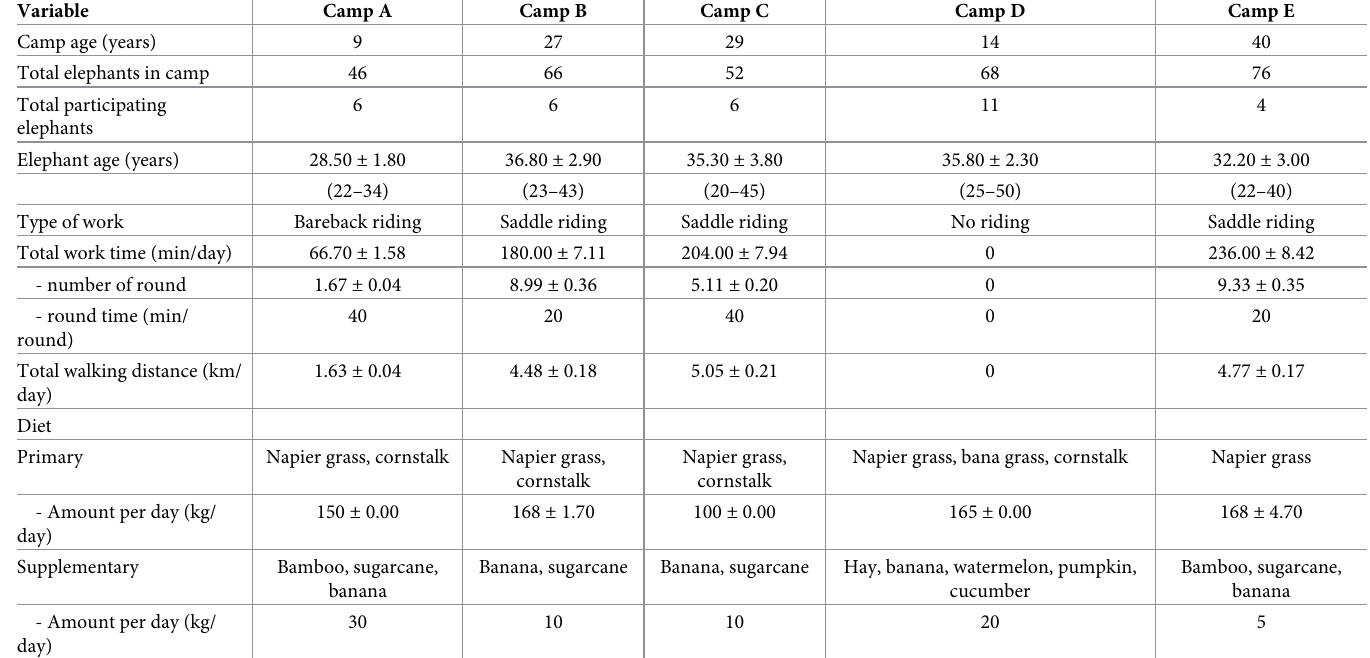
Table 1. Description of the elephant camps and elephants that participated in the study. Data were averaged over the 1-year study period during the High and Low tourist seasons and shown as mean ± standard error of the mean (SEM). Information includes the number of years the camp has been in operation (camp age), the total number of elephants in the camp, the number of female elephants participating in the study, participating elephant mean age and range, type of work with tourists, work time and walking distance per day, and primary and supplemental food